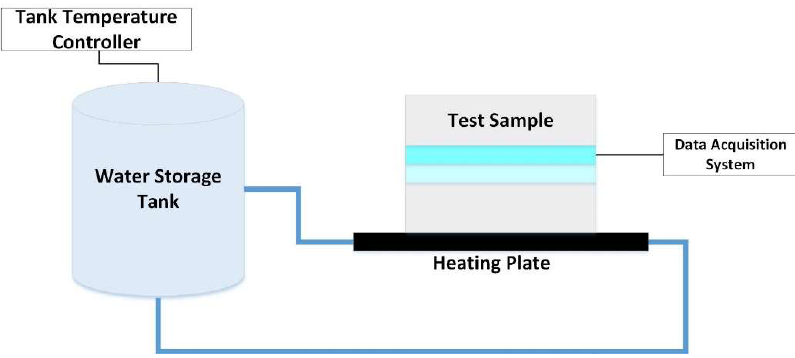
Figure 2. Schematic of an experimental test rig with components and connections.